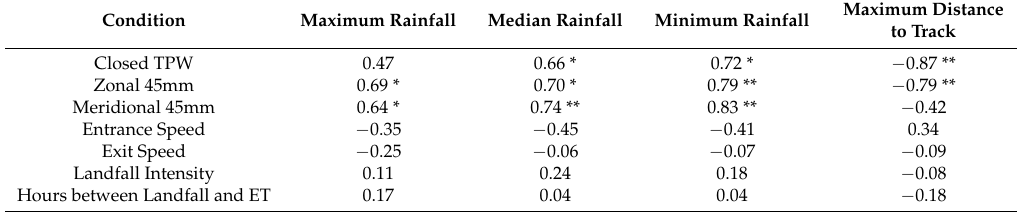
** significant at α = 0.01; * significant at α = 0.05.